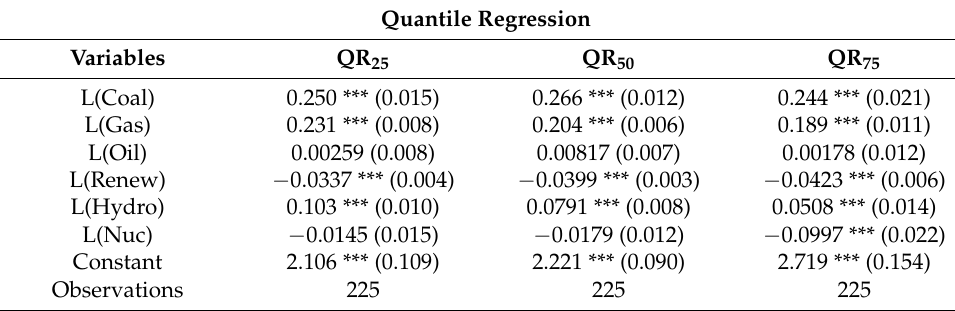
Table 5. Quantile Regression Output Result (L(EHCO 2